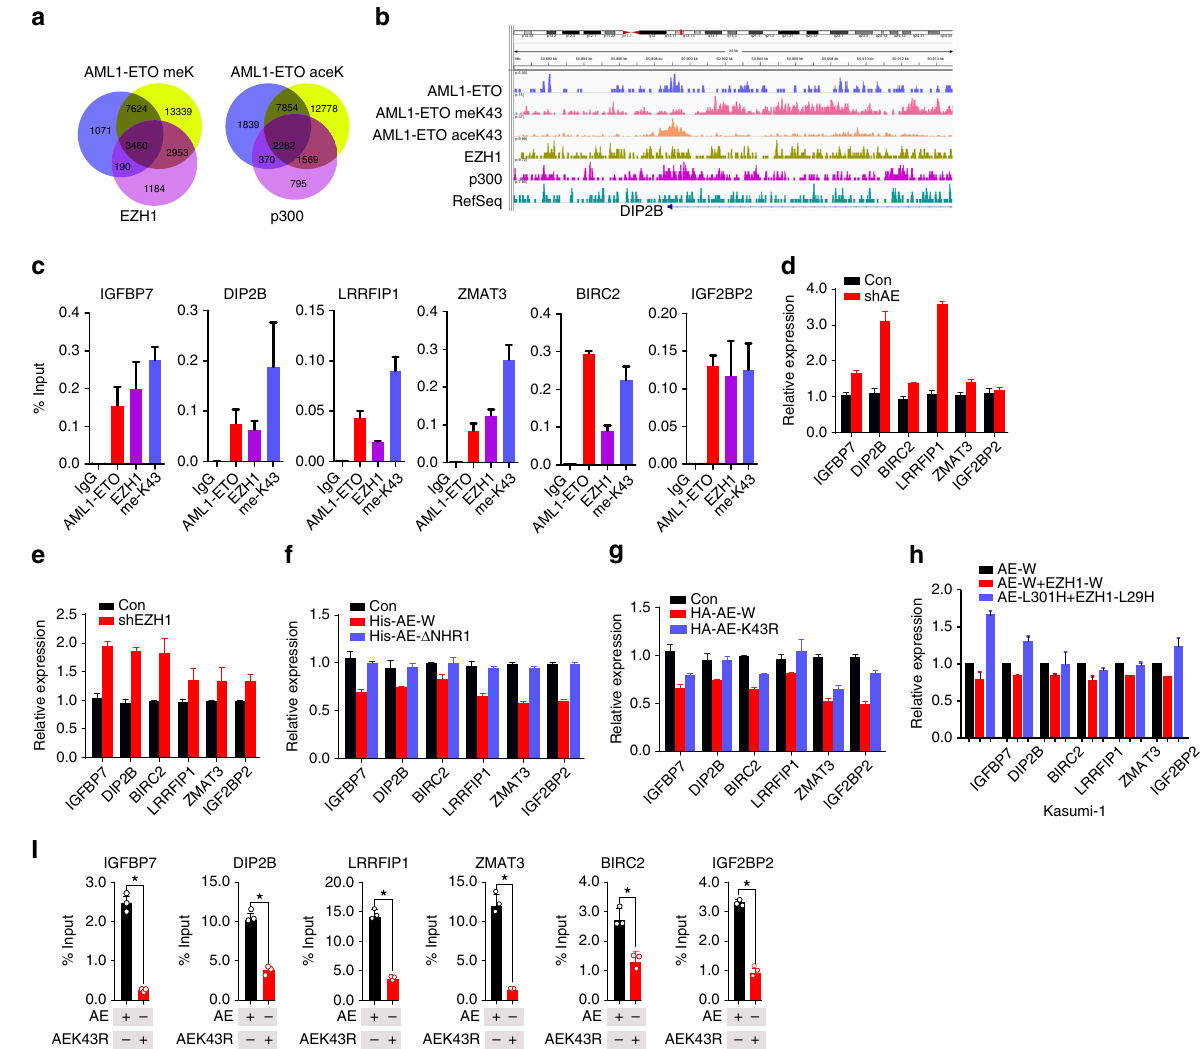
Fig. 5 AML1-ETO Lys43 methylation is essential for AML1-ETO transcriptional activity. a Venn diagram illustrating the number of genes in which the peaks of AML1-ETO co-localize with those of EZH1, p300, meK43, or aceK43 in Kasumi-1 cells determined by anti-AML1-ETO (speci fi c to AE, but not wild-type ETO or AML1), anti-EZH1, anti-p300, anti-meK43 (methylated AEK43, our developed antibody) or anti-aceK43 (acetylated AEK43, our developed antibody). b UCSC Genome Browser image depicting the human methylated K43-AML1-ETO and EZH1 loci demonstrating a co-localization of peaks at DIP2B promoter. c ChIP-qPCR showing the co-occupancy of AML1-ETO, EZH1, me-K43 at AML1-ETO target promoters in Kasumi-1 cells using an AML1- ETO speci fi c antibody, anti-EZH1 or anti-me-K43 ( n = 3). d , e qPCR for changes in the AML1-ETO and EZH1 target gene expression in Kasumi-1 cells with knockdown of AE ( d ) or EZH1 ( e ) ( n = 3). f , g qPCR for changes in AML1-ETO and EZH1 target gene expression in HEK293 cells transfected with AE-W (wild type), AE- Δ NHR1 or AEK43R ( n = 3). h qPCR for changes in AML1-ETO and EZH1 target gene expression in Kasumi-1 cells transfected with the indicated mutant constructs ( n = 3). i ChIP-qPCR assessing the enrichment of AE and AEK43R in the target promoters ( n = 3). * P < 0.05; Fig. i , one-way ANOVA; AE AML1-ETO, meK43 methylated AEK43, aceK43 acetylated AEK43. The data are representative of 3 independent experiments. Data are expressed as mean values ± S.D. Source data are included in the Source Data fi